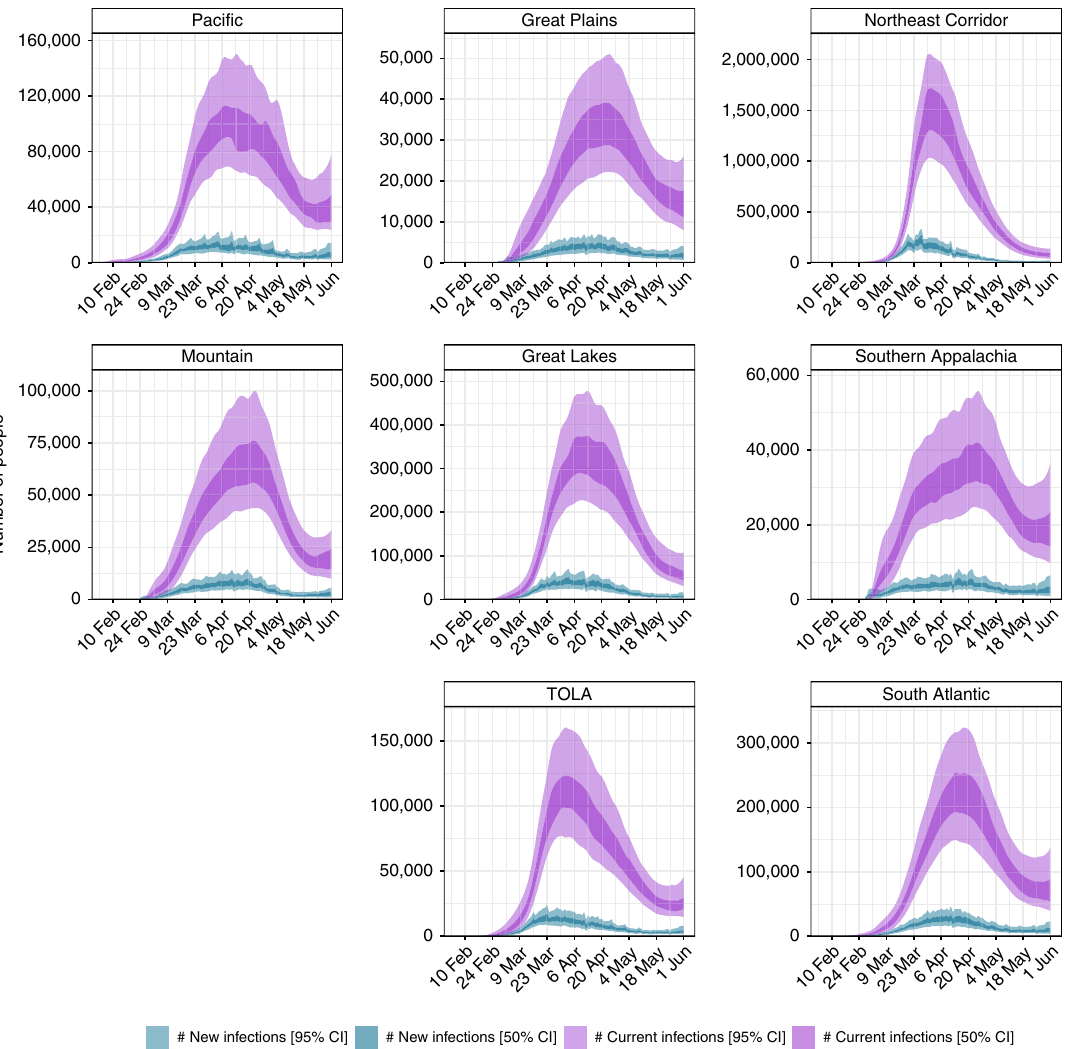
Fig. 1 Daily estimates of the number of infectious (those still able to transmit) individuals and newly infected individuals. The light purple band is the 95% credible interval (CI) of the number of infected individuals, dark purple the 50% CI of the number of infected individuals, light blue the 95% CI of the newly infected individuals and dark blue the 50% CI of the newly infected